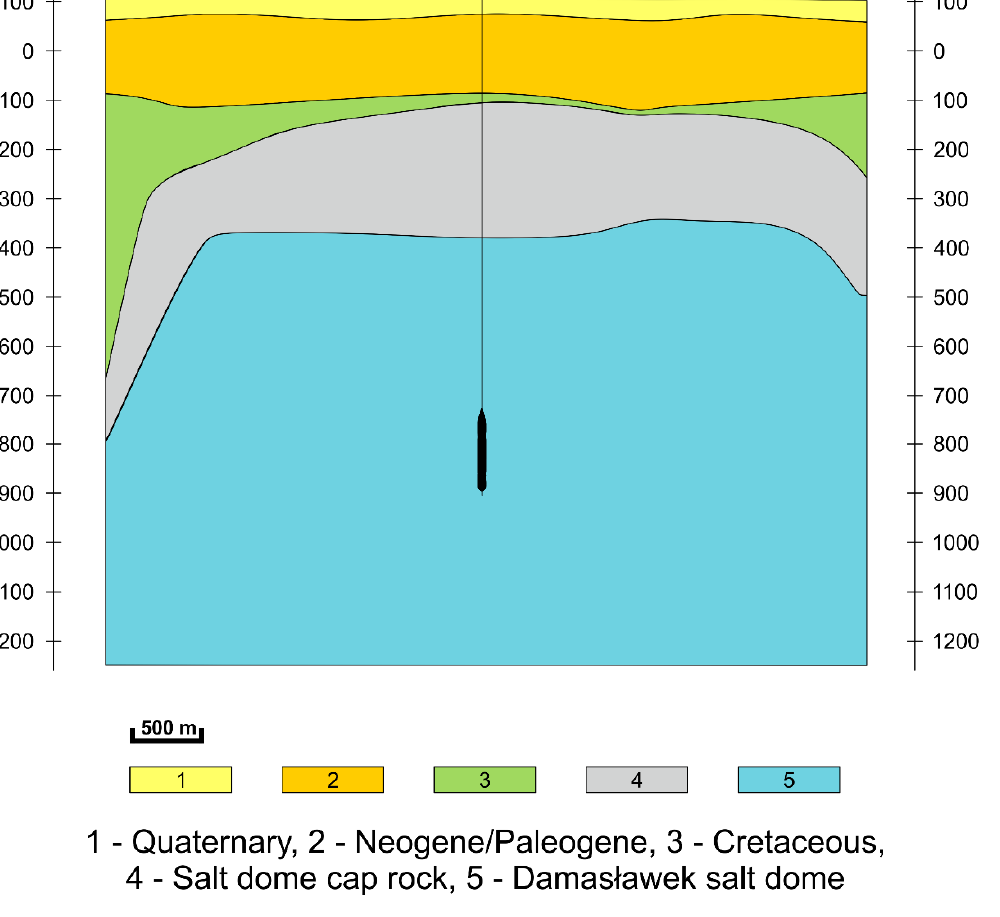
Figure 1. Interpretation of the Damasławek salt dome according to the Uncovered Geological Map (without Quaternary Cover) at the depth –400 m b.g.l.